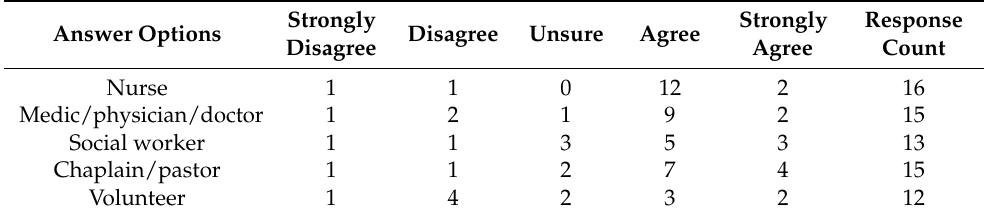
Table 10. Agreement on personnel that have overall responsibility for the assessment of spiritual needs as a basis for the provision of spiritual